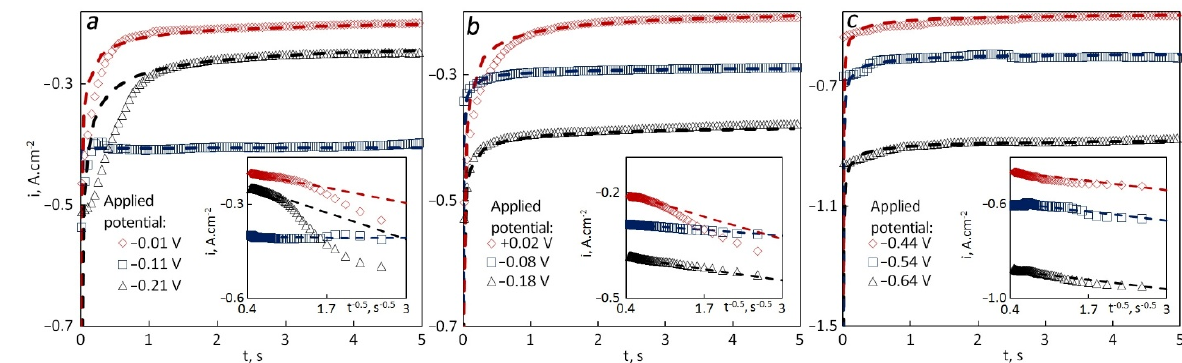
Figure 4. Chronoamperograms recorded for tungsten in 85LiF–15AlF 3 (with 5 wt.% of spent catalyst) at different applied potential and the dependencies of current density vs. time to the power − 0.5 (bottom right) for different temperatures: ( a ) 760 °C, ( b ) 780 °C, ( c ) 800 °C.